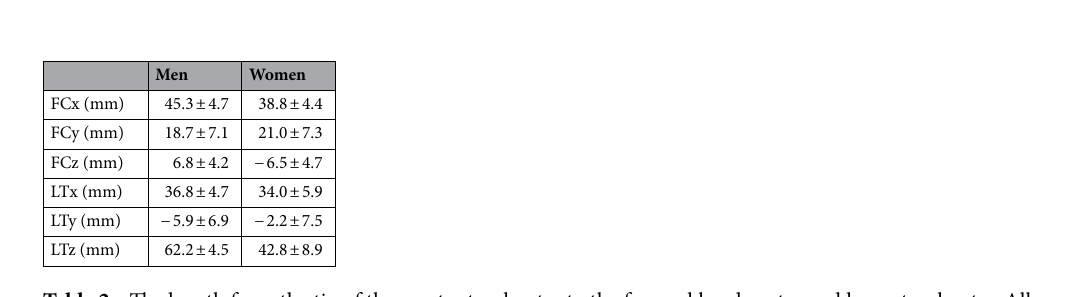
Table 2. The length from the tip of the greater trochanter to the femoral head center and lesser trochanter. All values are expressed as mean ± standard deviation.